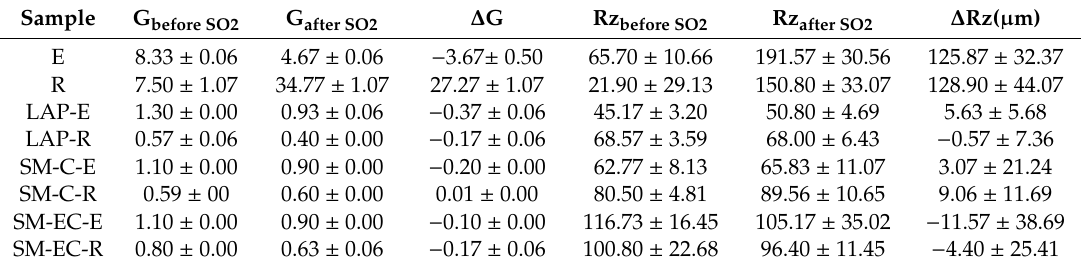
Table 2. Gloss values (G, gloss units), gloss variations ( ∆ G, gloss units), average maximum profile height (Rz, µ m), and respective variation ( ∆ Rz, µ m) of paint and binder mock-ups before (before SO 2 ) and after (after SO 2 ) SO 2 exposure, while considering the fresh samples as a reference. Standard deviations are also shown. Check Table 1 to better follow the paints